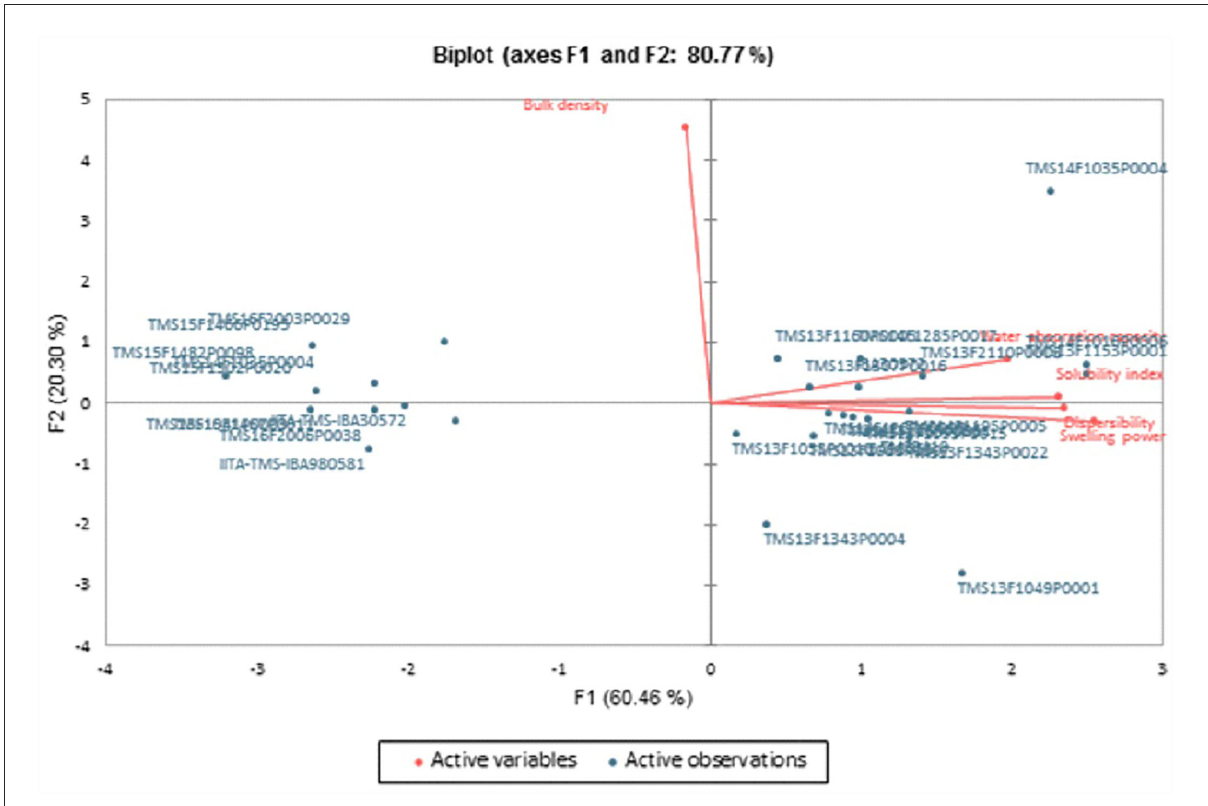
FIGURE1 The principal component analysis biplot of the functional properties of gari samples.